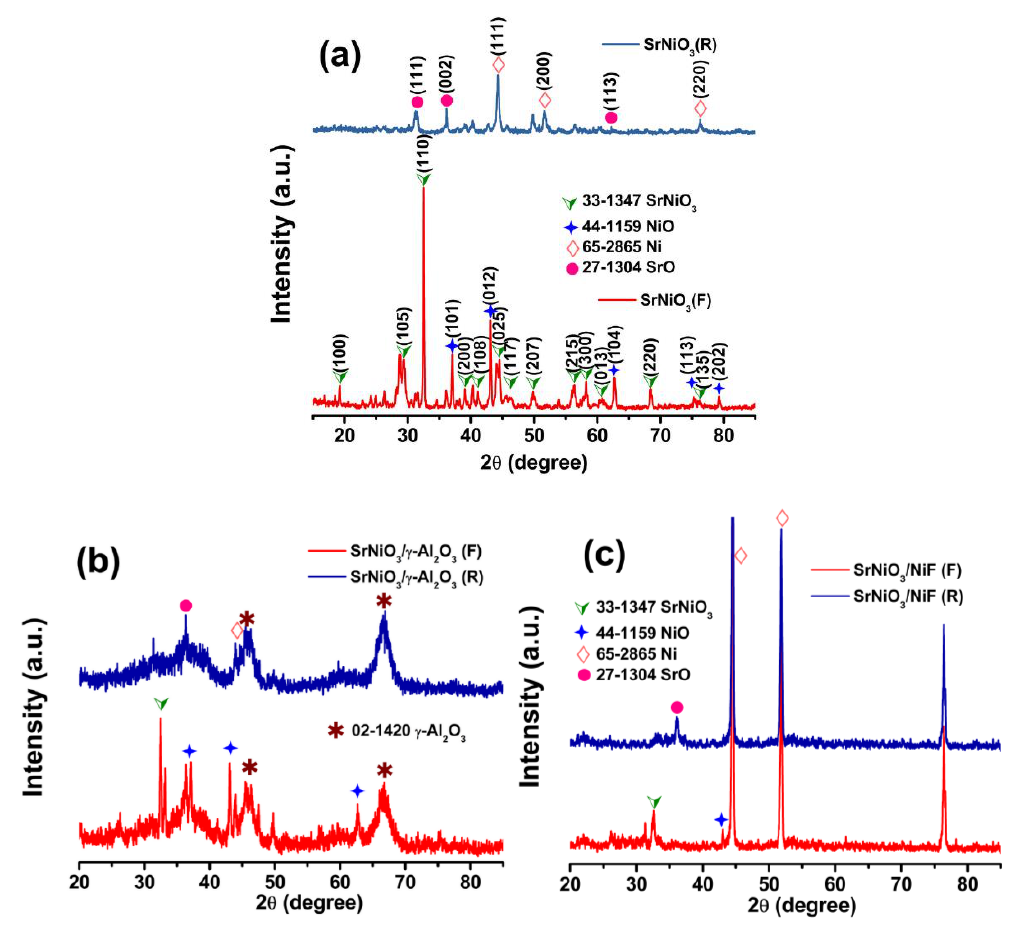
Figure 1. X-ray diffraction patterns of ( a ) SrNiO 3 unreduced (F) and reduced (R) perovskite catalysts ( b ) SrNiO 3 (F and R) supported in γ-Al 2 O 3 ( c ) supported in nickel foam.